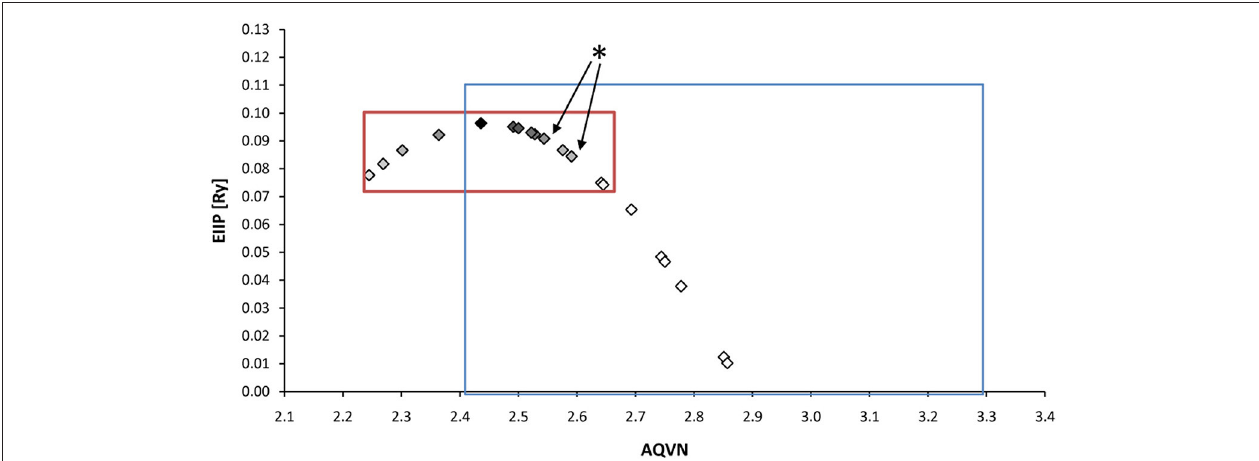
FIGURE 4 | Schematic presentation of the EIIP/AQVN criterion for selection of candidate antimuscarinic drugs with potential therapeutic effect on VVS. Active domain (red): AQVN (2.25–2.65), EIIP (0.074–0.096). Chemical space (blue) AQVN (2.40–3.30) EIIP (0.000–0.116) EIIP/AQVN domain of homologous distribution of > 90% compounds from PubChem Compound Database. Statistics: inside the active domain: 21 (78%), outside the active domain: 6 (22%). Asterisk ( * )-position of atropine and propentheline bromide, known anti VVS drugs, within AQVN/EIIP active domain.